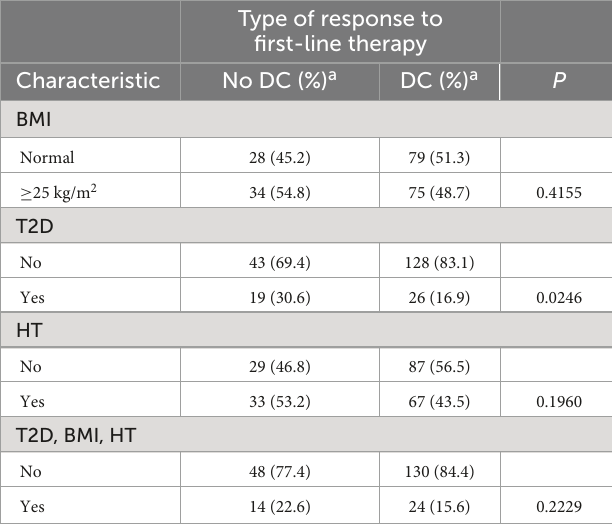
TABLE 2 Associations between BMI, T2D, HT, and response to first-line therapy.